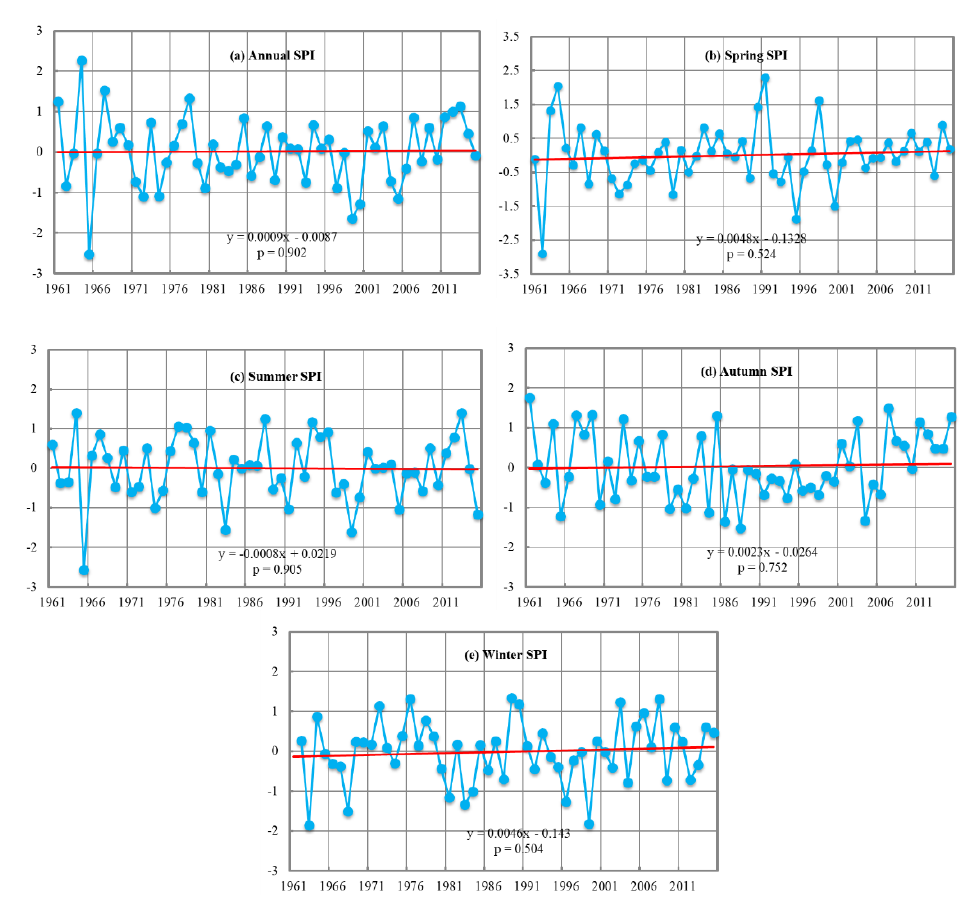
Figure 2. Variation characteristics of annual and seasonal standardized precipitation index (SPI) in Yulin City of the northern Shaanxi from 1961 to 2015. ( a ) Annual, ( b ) Spring, ( c ) Summer, ( d ) Autumn, ( e ) Winter.